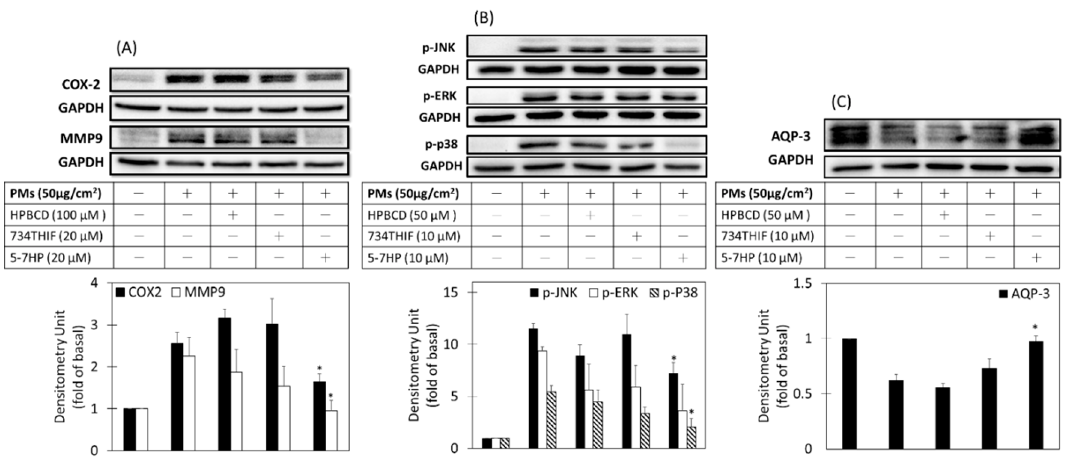
Figure 10. COX-2, MMP-9, AQP-3, and MAPKs protein expressions. Cells were pre-incubated with HPBCD, raw 734THIF, 5-7HP in DMEM solution for 24 h and then treated with PMs for 2 h (p-JNK, p-ERK, and p-p38, B ); 6 h (COX-2 and MMP-9, A ); 24 h (AQP-3, C ). n = 3 in each group; * p < 0.05 compared with the group of PMs.